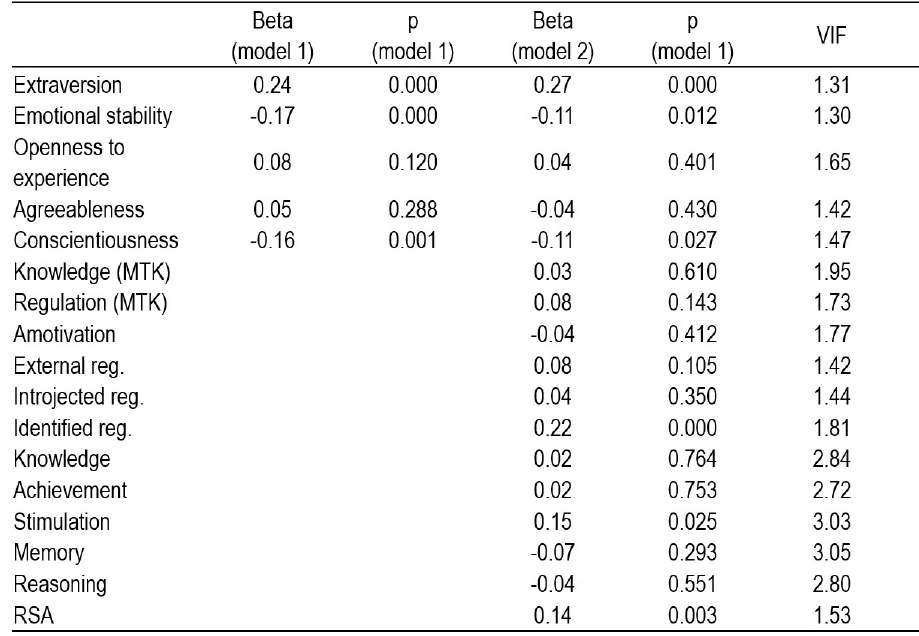
Table 3 Partial contribution of predictors in the hierarchical regression